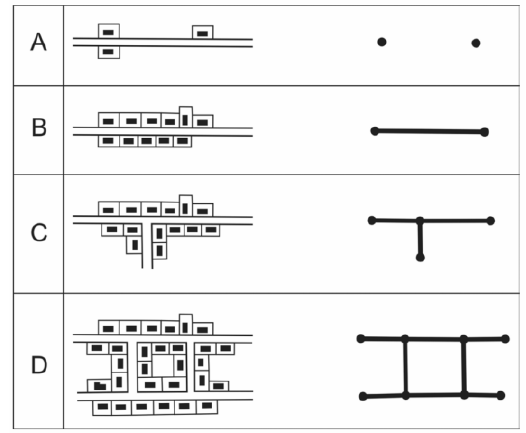
Fig. 2. Graphs identifying morphological layouts of